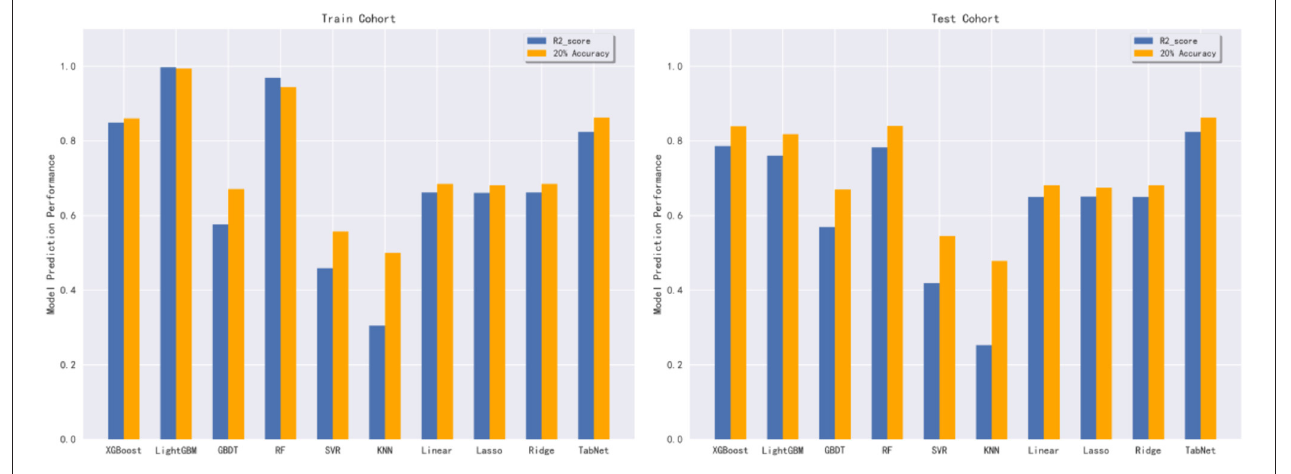
FIGURE 3 | Model prediction performance after the 5-fold